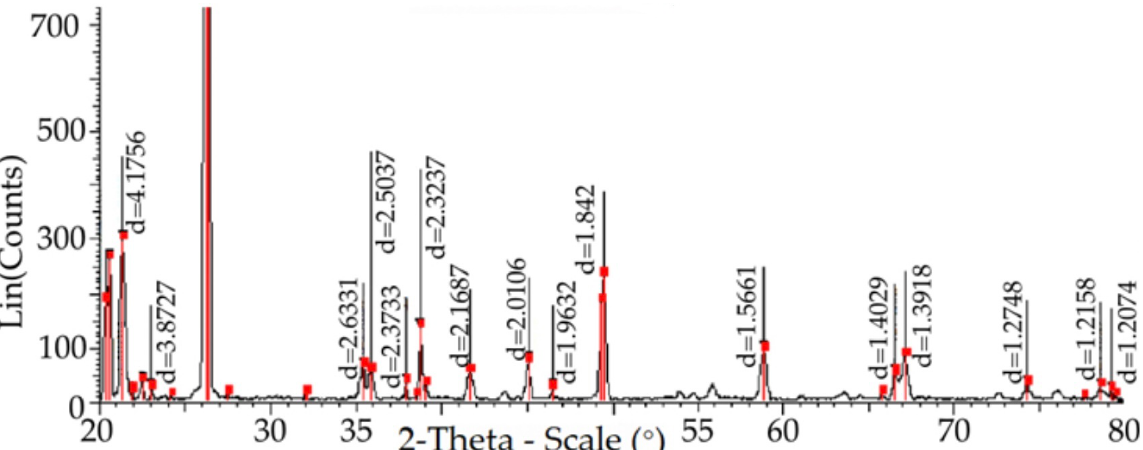
Figure 5. The structure of quartzite consists of elementary cells of cristobalite (colored purple, cards